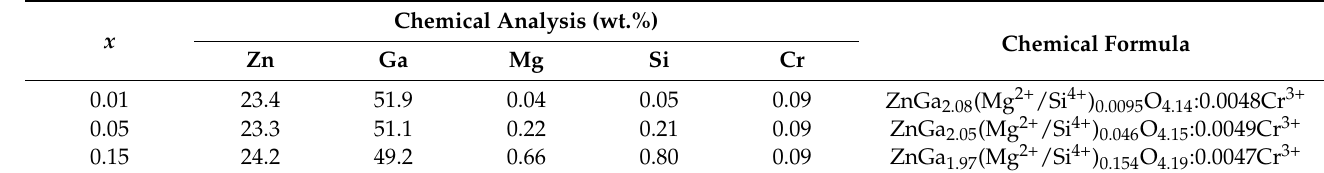
Figure 1. XRD pattern for the prepared ZGMSO:Cr 3+ ( x = 0 – 0.20) calcined at 1000 °C.